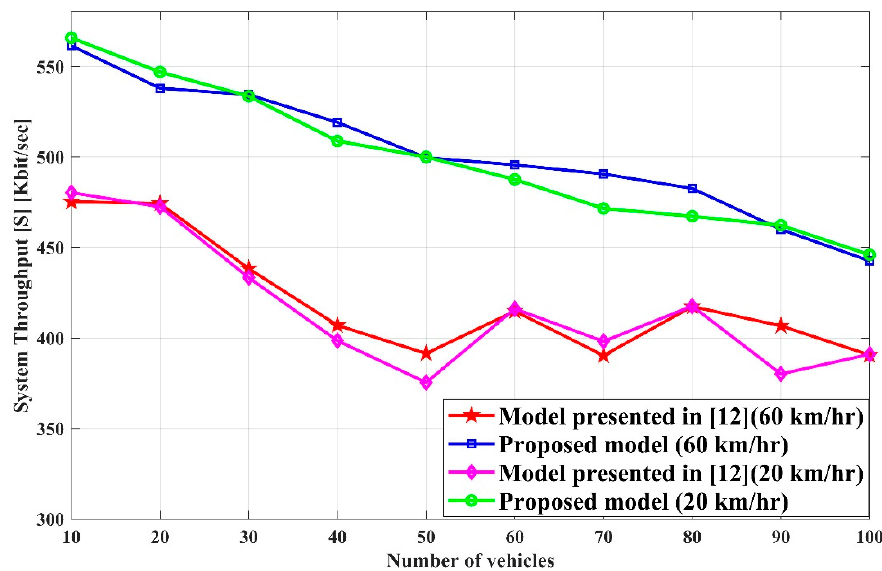
Figure 8. System throughput vs. number of vehicles.